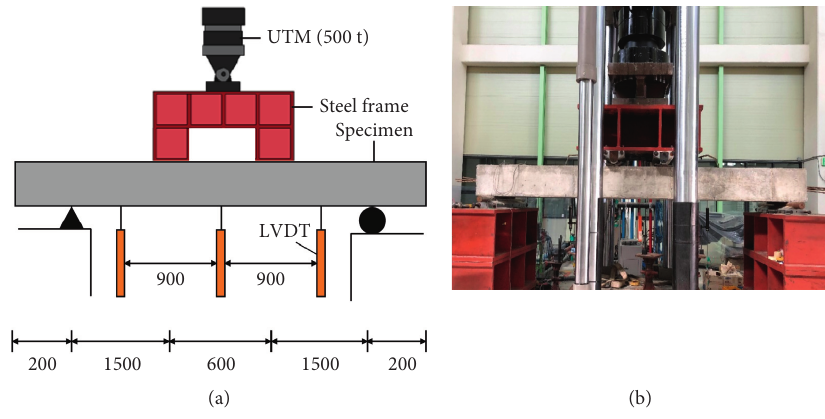
Figure 4: Test setup. (a) Schematic test setup. (b) Photograph of test setup.